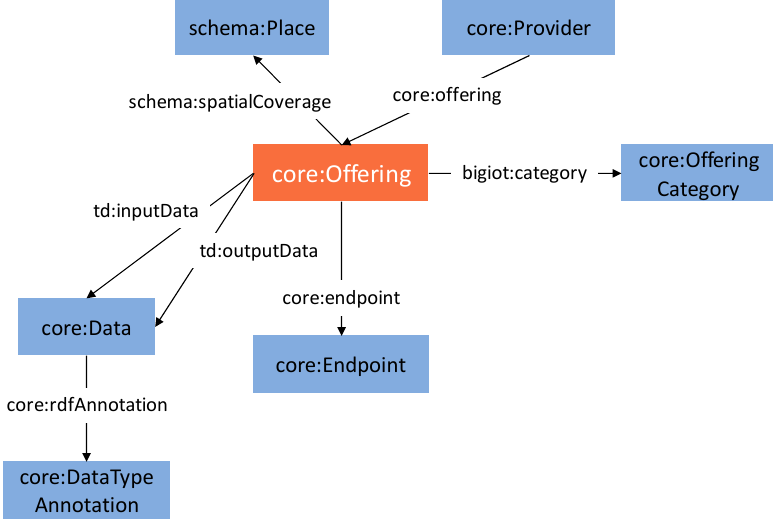
Figure 4. BIG-IoT Semantic Application Domain Model [44] excerpt.